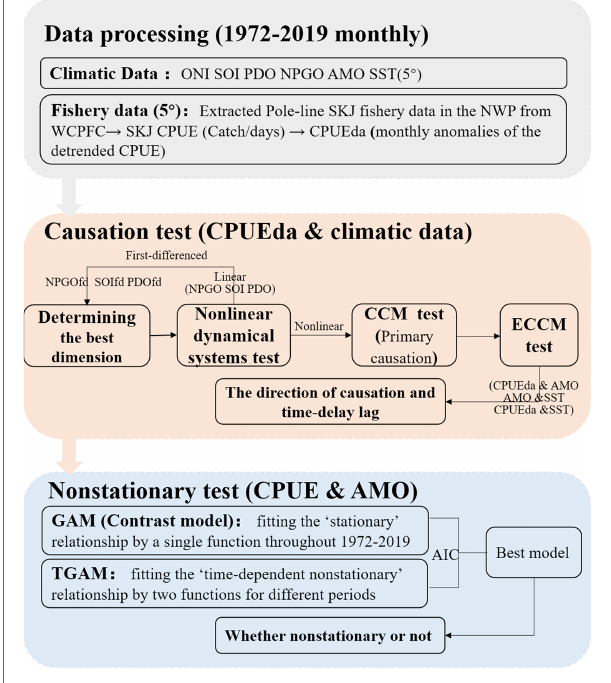
FIGURE 2 | Flow chart of the statistical methods conducted in this